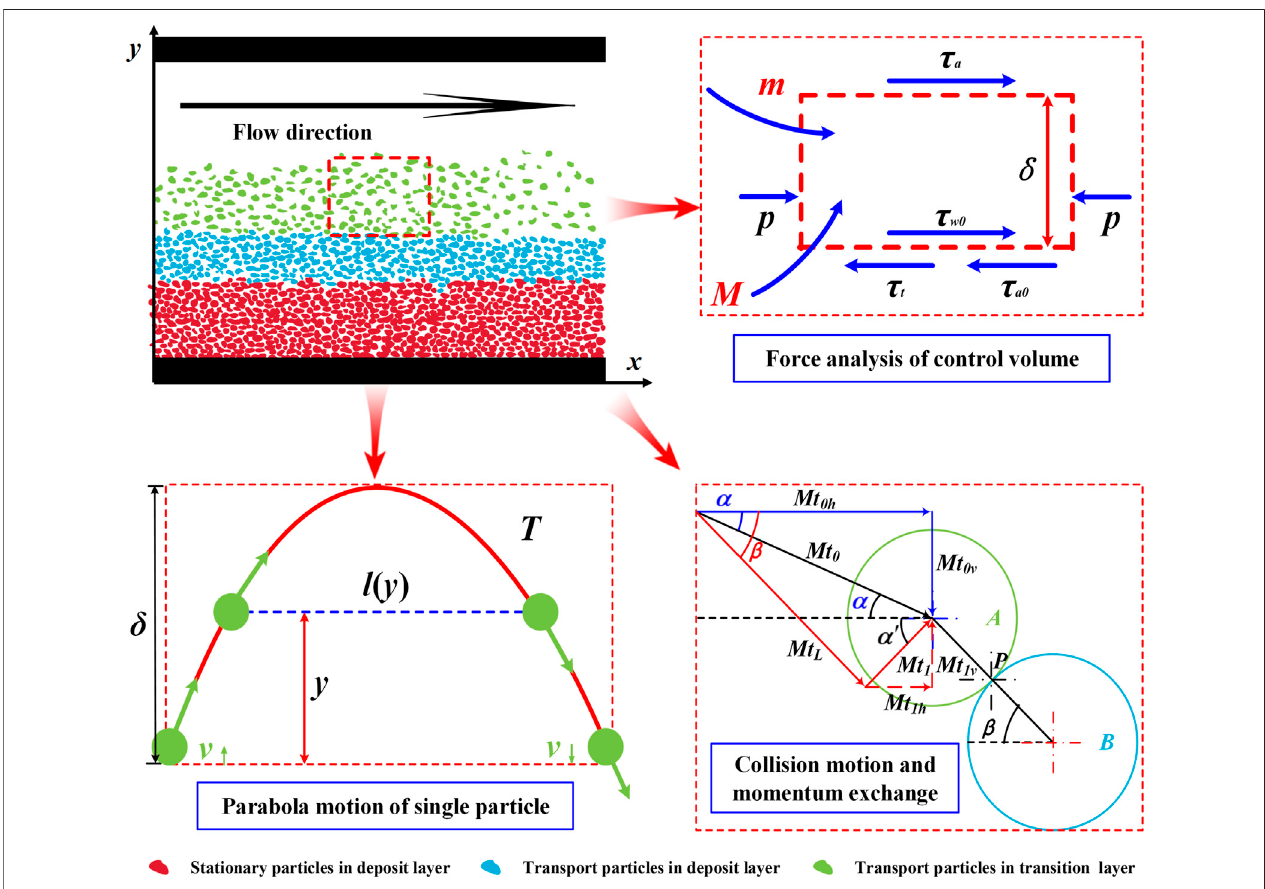
FIGURE 1 | Momentum distribution of transported particles and static particles on the sedimentary